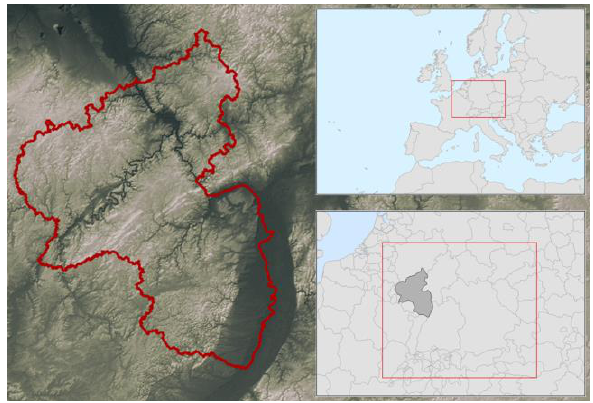
Figure 1: Rhineland-Palatinate, terrain and situation (Illustr. by